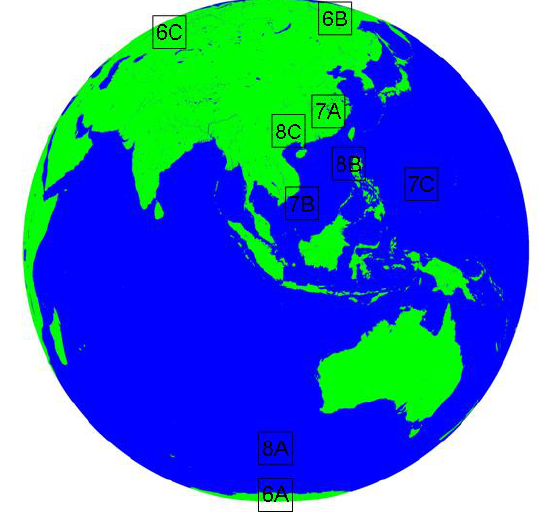
Figure 5. Location of cases: 6X (6A, 6B,6C) is the location of case A, B, C in high latitude (Figure 6); 7X (7A, 7B,7C) is the location of case A, B, C of Cumulonimbus (Figure 7); and 8X (8A, 8B, 8C) is the location of case A, B, C of cirrus (Figure